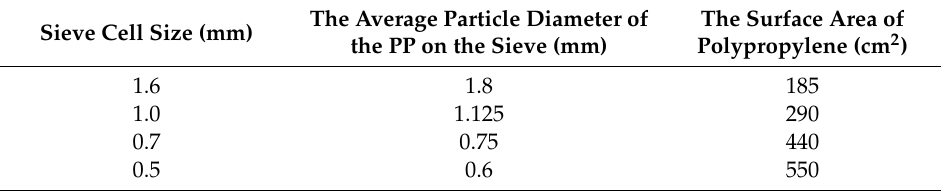
Table 1. The dependence of the surface area of 5 grams of polypropylene on the particle size.